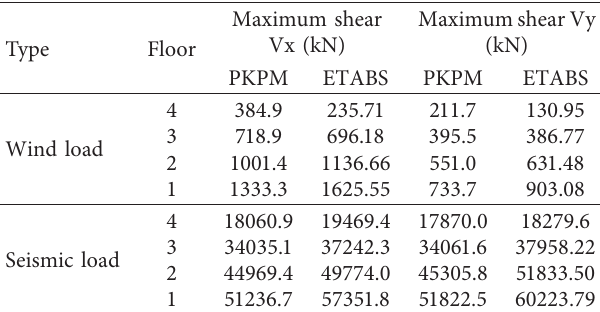
Figure 6: X-direction structural vibration mode diagram calculated by (a) PKPM and (b) ETABS. Note. Model data: building area: 48m × 96.4 m; grid: 9.6 × 9.6; storey height: 7.65m +5.5m x3. Table 7: Comparison of internal forces calculated by PKPM and ETABS for structures subjected to earthquake